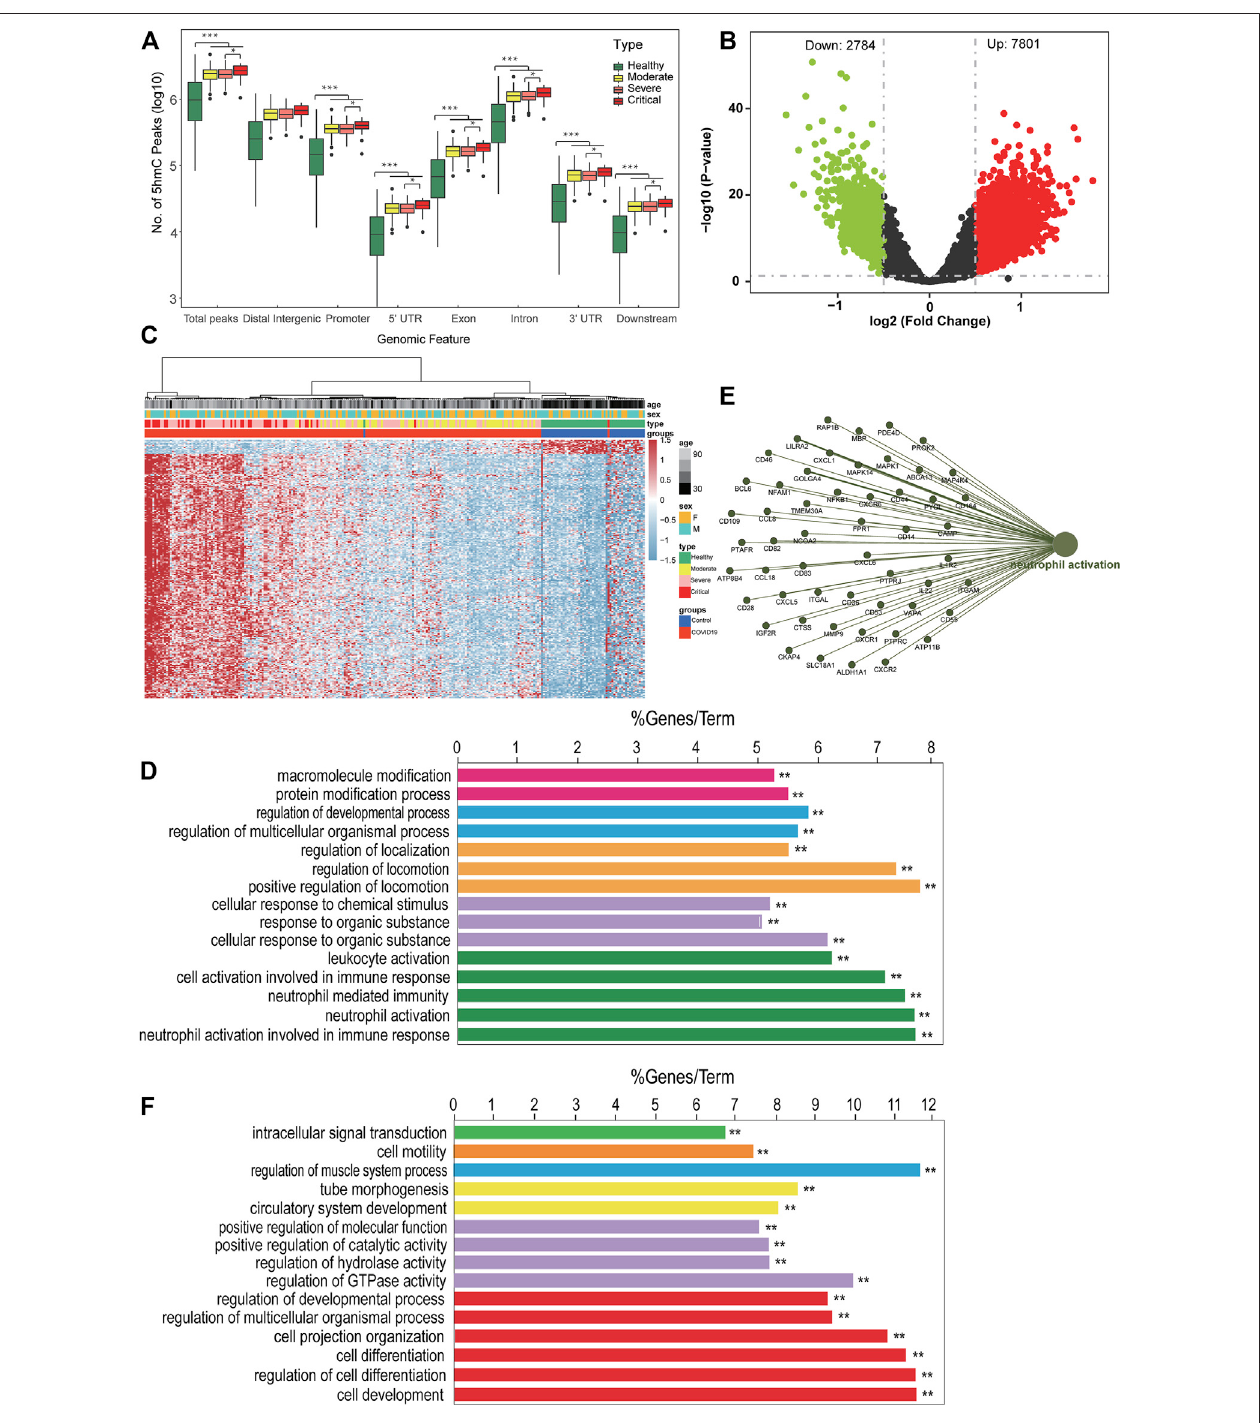
FIGURE 2 | The landscape of 5hmC in circulating cell-free DNA of patients with COVID-19. (A) Genome-wide 5hmC distribution in different genomic features grouped by patients with COVID-19 (** p < 0.01). (B) Volcano plot (patients with COVID-19 vs. healthy control). Signi fi cantly altered hMRs [abs (log2FoldChange) ≥ 0.5; p -value < 0.01] are highlighted in red (up) or green (down) using the COVID-19 groups as the reference. Black dots represent the hMRs that are not differences. (C) Heatmap of 203 patients with COVID-19 and 53 healthy control based on top 200 DhMRs (|log2FoldChange| ≥ 0.5 and p < 0.01). (D – F) GO enrichment analysis and function exploration of 5hmC markers using Cytoscape software ( p < 0.01). GO enrichment with 5hmC increase (D) or decrease (F) in patients with COVID-19. (E) GO enrichment and Gene-Concept Network. hMRs, 5 hMc-enriched regions; DhMRs, differentially 5hMc-enriched regions.